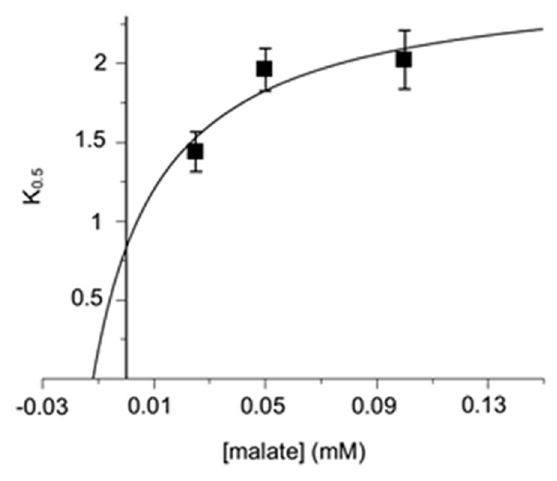
Figure 3. Second-order plot of the data from Figure 2. The dependence of K 0.5 was obtained from Figure 2 on the external labeled malate. The R 2 calculation obtained using a quadratic regression model was equal to 0.862, better than the one obtained by using a linear regression model (0.665).